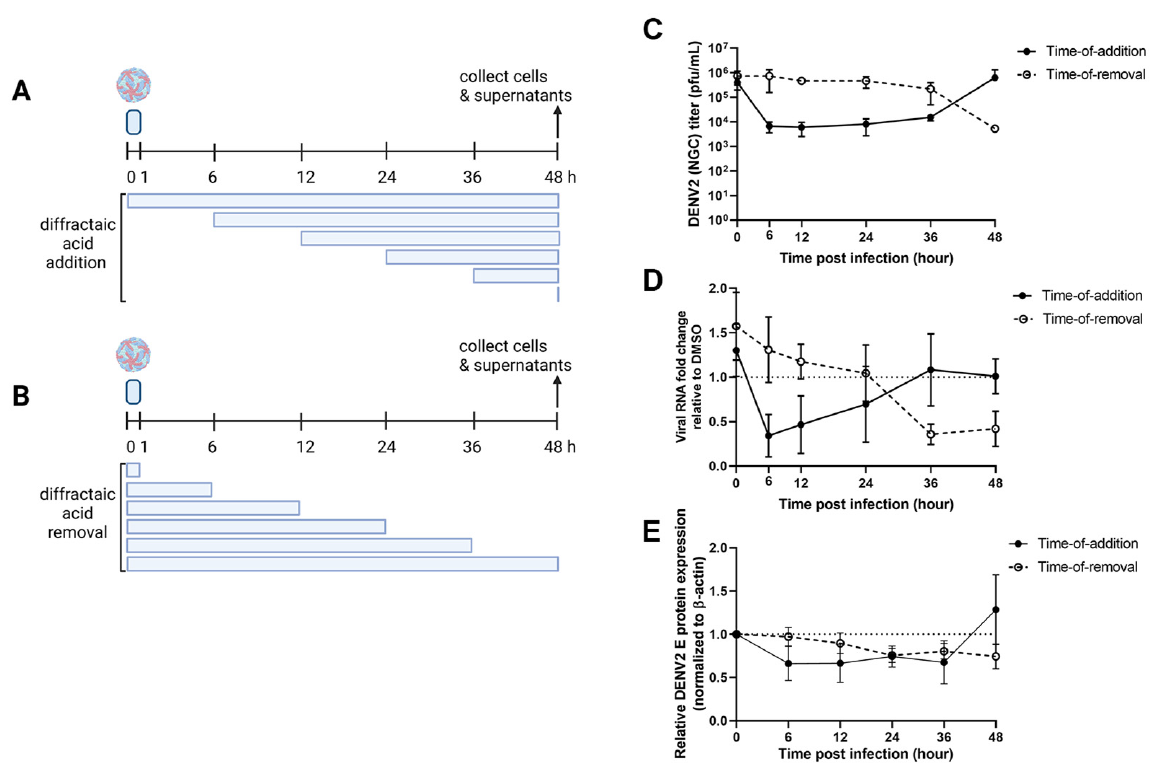
Figure 3. Effect of diffractaic acid on DENV2 virion, RNA, and protein expression. ( A , B ) Schematic of the perion of compound incubation (blue rectangles) in DENV2-infected Vero cells (MOI of 1). ( C ) Supernatants of the compound-treated samples were collected for DENV2 plaque titration. ( D ) Viral RNA was quantified by RT-qPCR and calculated as the fold change expression relative to DMSO-treated control. ( E ) Cell lysates were subjected to SDS-PAGE and Western blot to quantify DENV2 E protein expression. The anti- β -actin antibody was used as the loading control. The relative band intensities of DENV2 E protein from three independent experiments were calculated. The dotted line at 1.0 (y-axis) in ( D , E ) represents the equal expression of compound treatment compared to DMSO control.